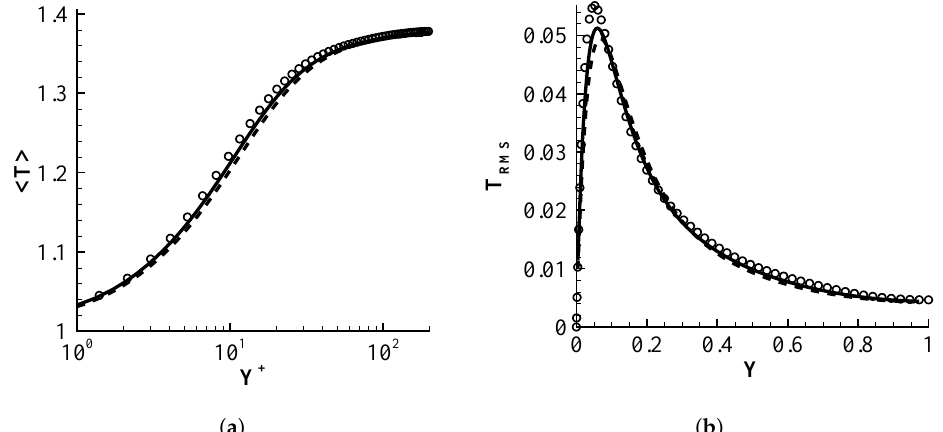
Figure 3. ( a ) Mean temperature profiles in wall units and ( b ) RMS temperature profiles in wall coordinates. Notations are the same as those in Figure